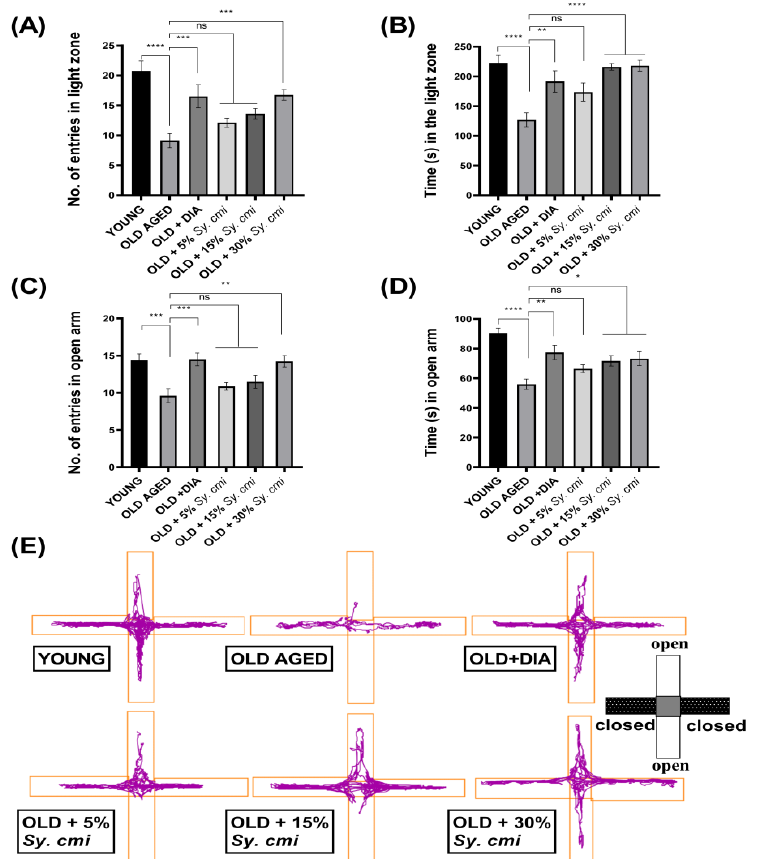
Figure 4. The mice ( n = 8) supplemented with 5, 15, and 30% dilutions of Sy. cmi for 16 months were tested for anxiety-like behavior in light/dark and elevated plus-maze tests, and their exploration of both mazes for 5 min was evaluated for ( A ) number of entries in light zone, ( B ) time in light zone, ( C ) number of entries in open arms, ( D ) time in open arms, and ( E ) representative track plots of animal’s activity in the elevated plus-maze. The outcomes of all groups were compared with the aged control group and * p < 0.05, ** p < 0.01, *** p < 0.001, **** p < 0.0001 were considered statistically significant while ns showed non-sgnificant outcomes for all data presented as mean ± SEM.Moreover, animals have been further tested for their entries and duration of stay in the open and closed arms of the EPM. The outcomes of ANOVA reveal a significant difference among groups for entries in open arms (F (5,42) = 6.74, p = 0.0001) and time spent there (F (5,42) = 9.10, p < 0.0001). In comparison to young mice, the older untreated mice show noticeably fewer entries in open arms ( p = 0.0008) and duration of open-arm exploration ( p < 0.0001). However, this increase in age-related anxiety-like behavior has been ameliorated in mice chronically treated with Sy. cmi . As compared to geriatric mice, nourishment with 30% Sy. cmi results in increased entries in open arms with p = 0.001 (Figure 4C), and these mice explore the open arms for a longer duration with p = 0.011 (Figure 4D). The outcomes with 15% Sy. cmi are also noticeable in terms of duration of stay in open arms with p = 0.024, but the observed parameters remain non-significantly changed in mice administered with 5% Sy. cmi